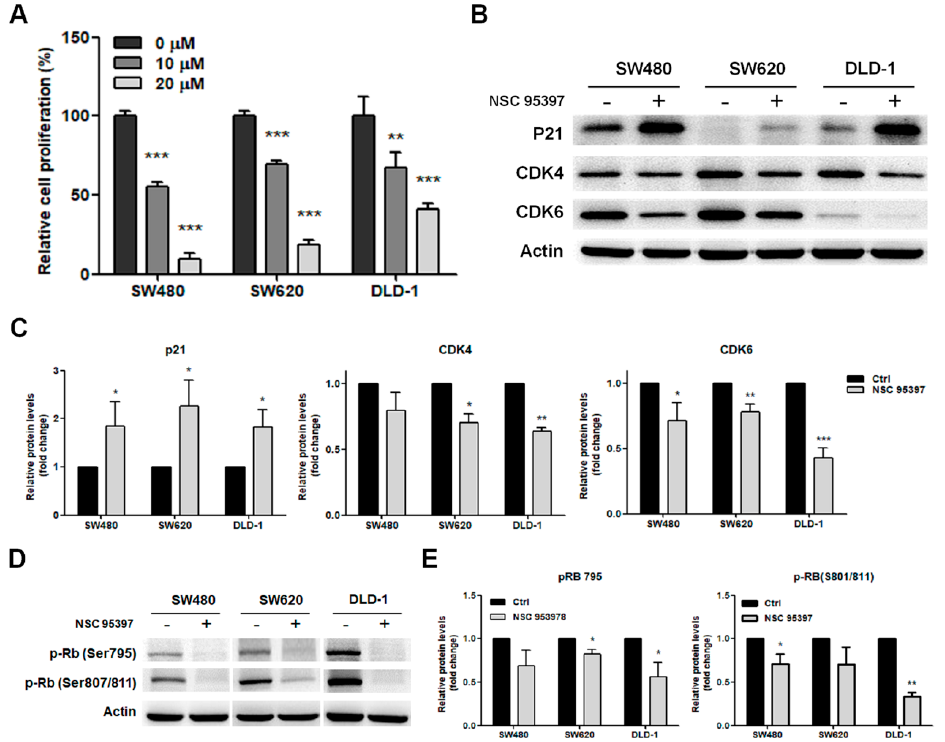
Figure 3. Inhibitory effect of NSC 95397 on cell proliferation and expression of cell cycle regulatory proteins. ( A ) In vitro cell proliferation (mean + SD) of SW480, SW620, and DLD-1 cells treated with indicated concentrations of NSC 95397 for 24 h assessed by BrdU assay; ** p < 0.01; and *** p < 0.001 using one-way ANOVA, compared to vehicle control (0 µM); ( B ) Representative Western blots showing expression of CDK4, CDK6, and p21 in SW480, SW620, and DLD-1 cells treated with 10 µM NSC 95397 for 24 h, with actin as loading control; ( C ) Quantitative analysis of the relative protein expression of p21, CDK4, and CDK6 normalized actin. Values (means + SD) are normalized to actin loading control; * p < 0.05; ** p < 0.01; and *** p < 0.001 using paired t -tests, compared to control group; ( D ) Representative Western blots showing of the phosphorylation of Rb at Ser795 and Ser807/811 in SW480, SW620, and DLD-1 cells treated with 10 µM NSC 95397 for 24 h, with actin as loading control; ( E ) Quantitative analysis of the relative protein phosphorylation of Rb at Ser795 and Ser807/811 normalized actin. Values (means + SD) are normalized to actin loading control; * p < 0.05; and ** p < 0.01 using paired t -tests, compared to control group.